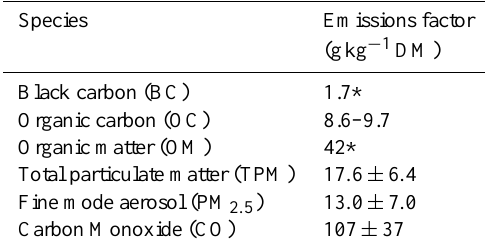
Table 4. Trace gas and particulate smoke emission factors ( η) for species ( s ) based on extratropical forest fuels, taken from Andreae and Merlet